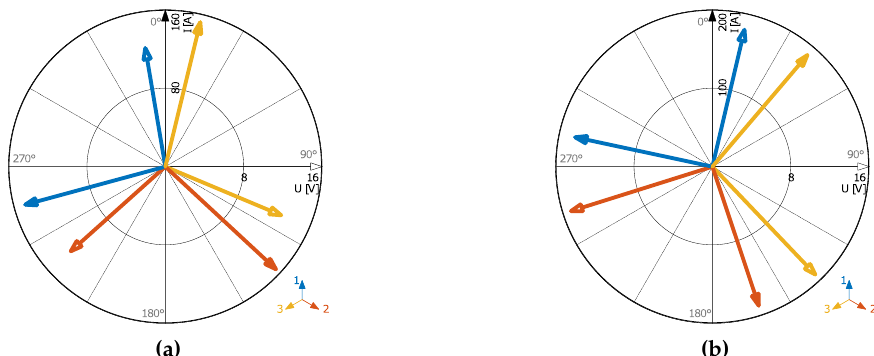
Figure 15. C2—Vector diagram of 5th harmonic of the secondary voltage and current of transformer T1 ( a ) before and ( b ) after switching on the capacitor stage.